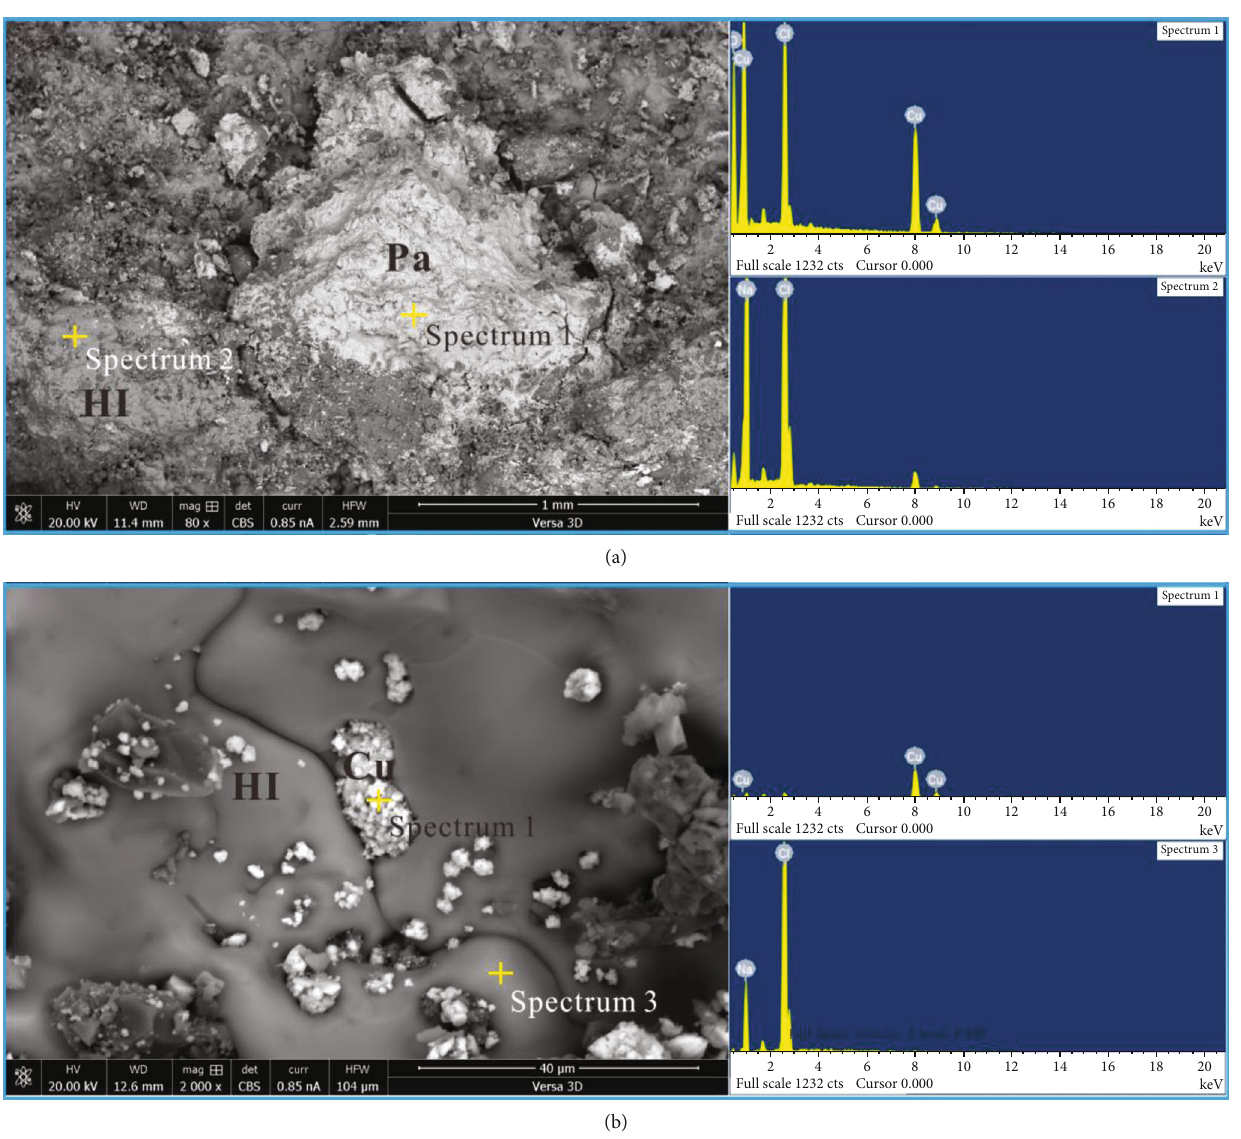
Figure 4: SEM and EDS analysis of sample KC-G . (a) and (b) are BSE images whereas the rest of the graphs are EDS spectrums. Pa: 2 paratacamite; HI: halite; Cu: natural copper. (a) Left: SEM image; right: EDS graph. The white mineral containing Cu, Cl, and O is paratacamite (Cu (OH) Cl). The grey mineral containing Na and Cl is halite (NaCl). (b) Left: SEM image; right: EDS graph. The white 2 3 mineral containing Cu is natural copper (Cu). The grey mineral containing Na and Cl is halite